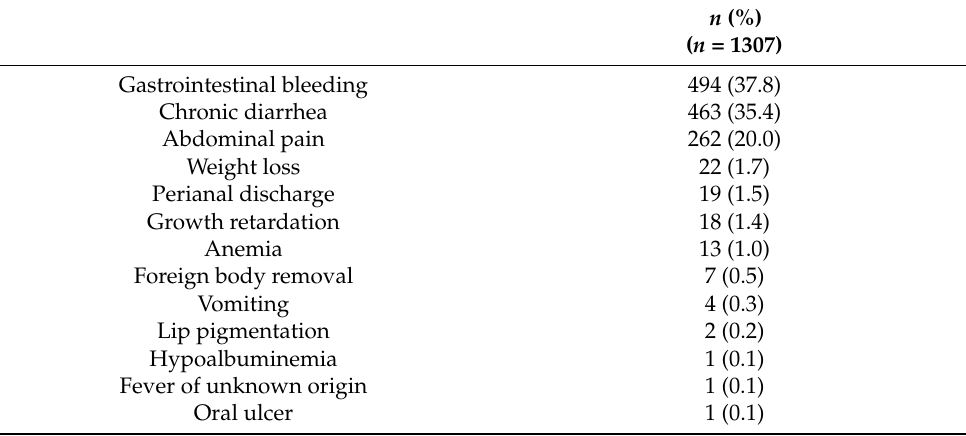
Table 2. Indications for lower gastrointestinal endoscopy.